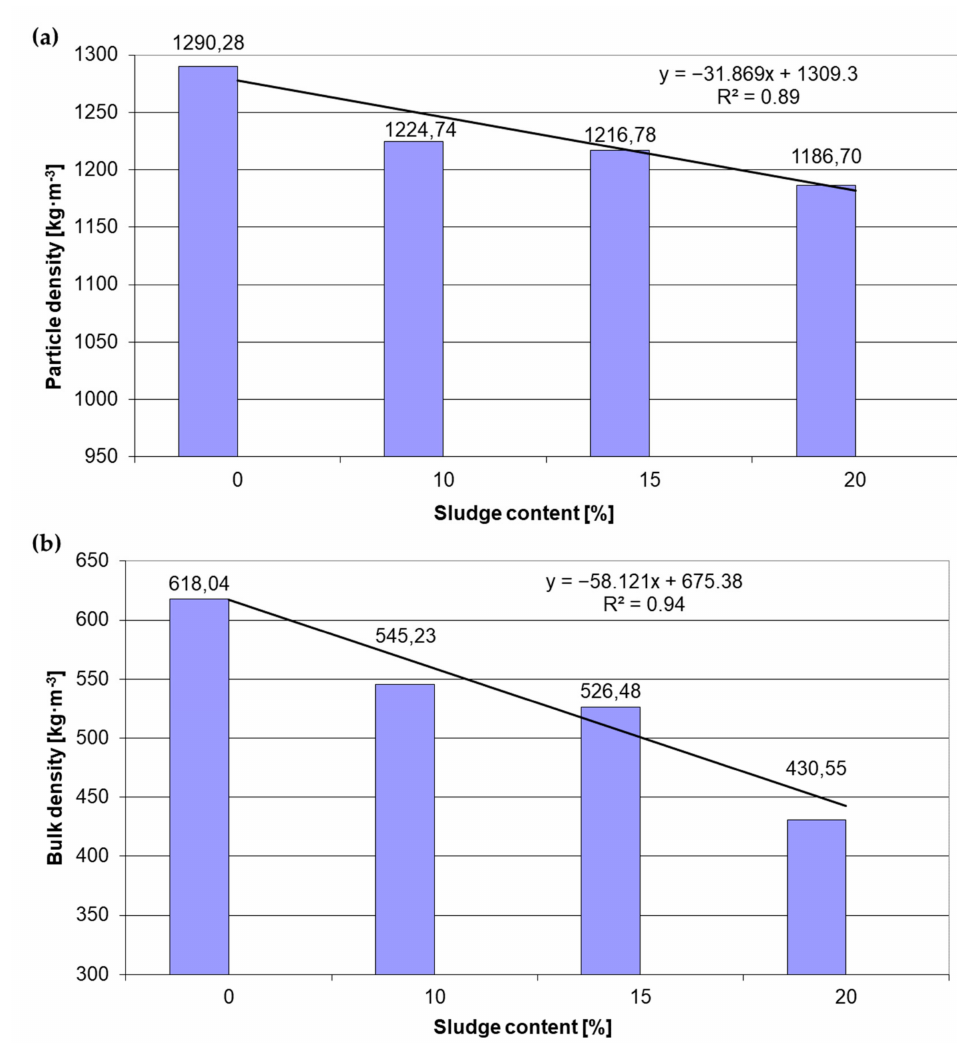
Figure 7. Influence of post-flotation dairy sewage sludge in a mixture with sawdust on: ( a ) particle density and ( b ) bulk